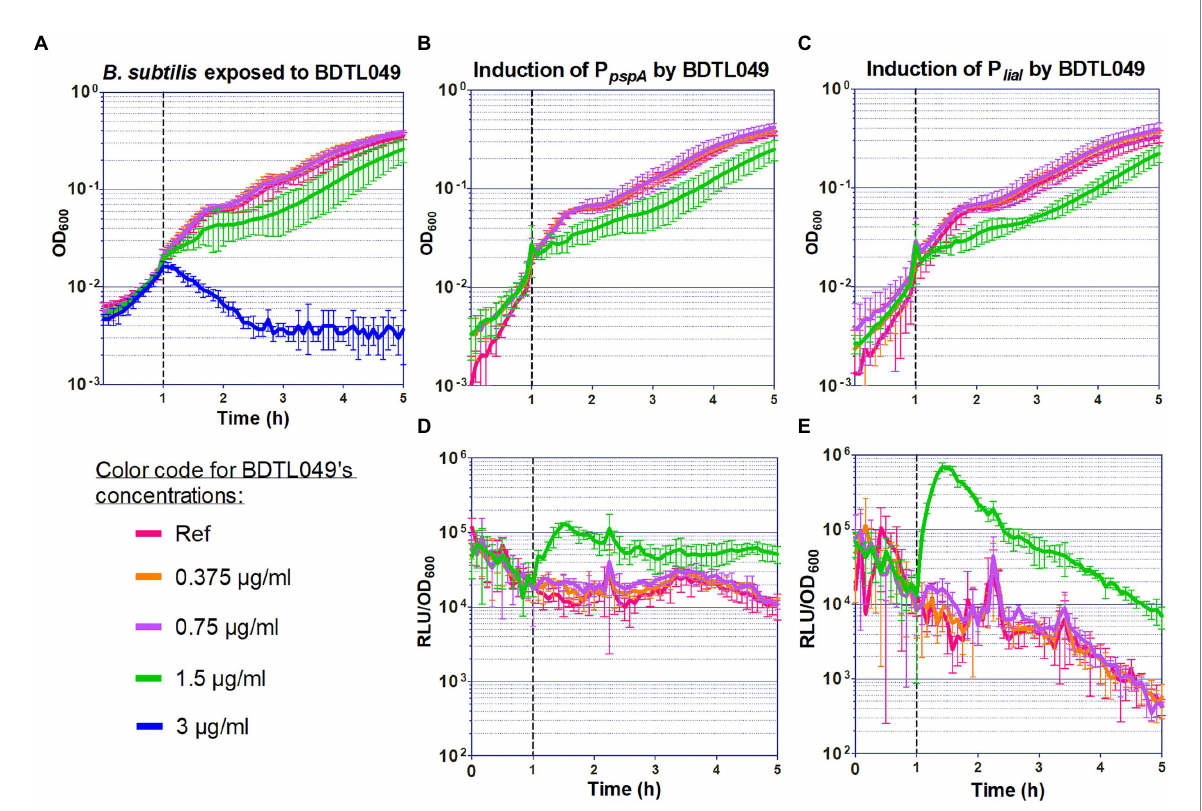
FIGURE 3 Sensitivity of Bacillus subtilis toward BDTL049, and induction of whole cell biosensors by BDTL049. (A) The effect of the addition of increasing concentrations of BDTL049 on the growth of exponentially growing wild type cells ( B. subtilis W168) was determined by monitoring OD 600 over time. The compound concentrations are indicated below the graph. (B–E) Induction of the P pspA (B,D) and P liaI (C,E) promoters by BDTL049 in liquid media. The effect of antibiotic exposure on growth is indicated as OD 600 (B,C) , and promoter induction as relative luminescence units by OD 600 (D,E) . The time of antibiotic addition is indicated by a vertical dashed line. The antibiotic concentrations used are color-coded according to graph (A) . The results presented in (B–E) correspond to strains TMB2299 (P pspA ) and TMB3822 (P liaI ). All experiments were performed at least in triplicate. Means and SDs are